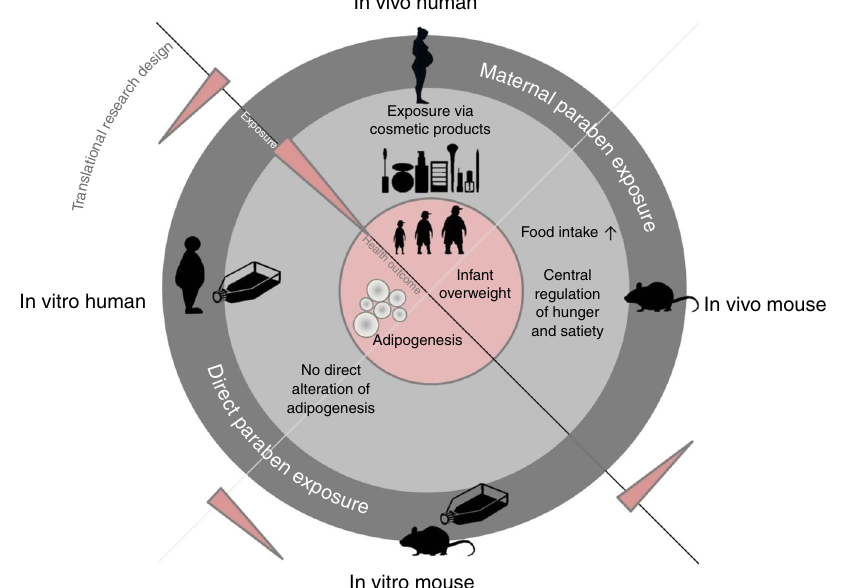
Fig. 5 Translational research design. Summary scheme of the present investigations describing the complex translational research design of the study. Findings from the prospective birth cohort study LINA were used to establish hypothesis driven approaches in human and mouse in vitro studies. Based on these results overall mechanistic analyses were addressed in the fi nal mouse in vivo